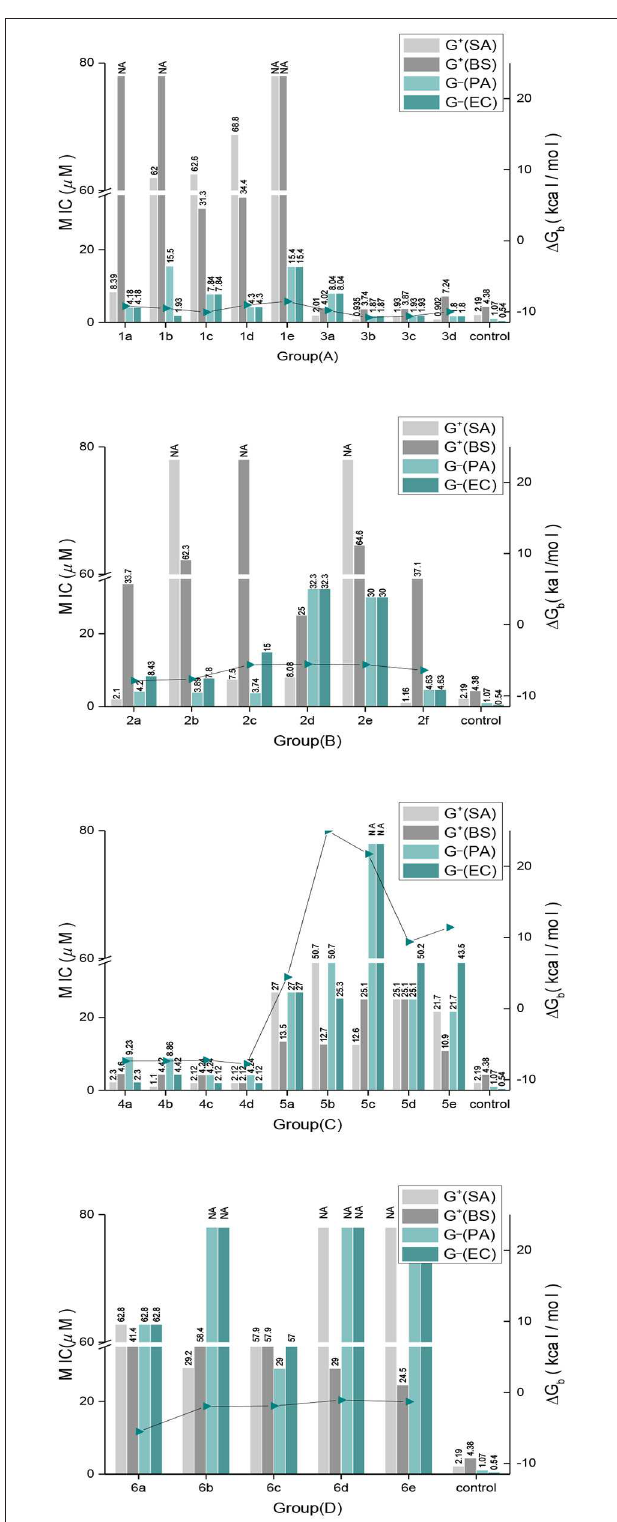
FIGURE 3 | The correlation between antimicrobial activities and the binding free